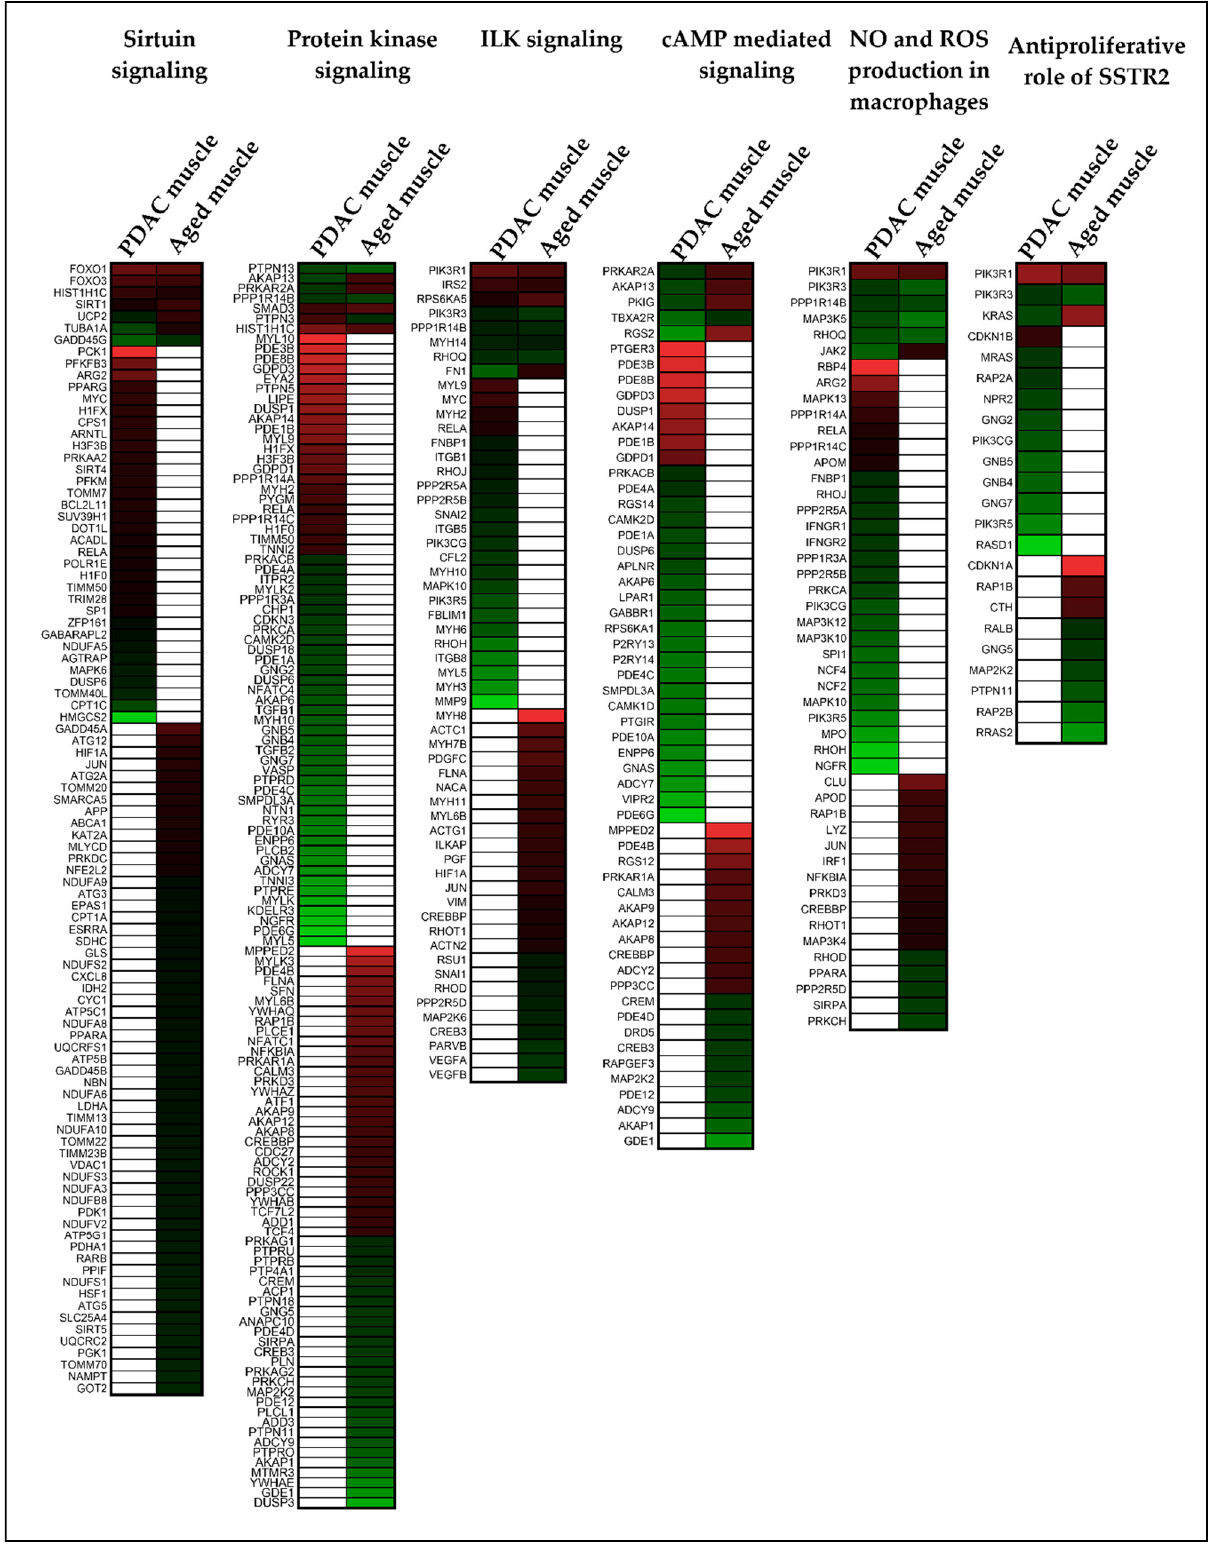
Figure 11. Comparison of age-related transcriptome against PDAC muscle. Six Common pathways were identified between GSE9676 and IU PDAC muscle dataset. Heatmap for each pathway indicate that genes identified in aged muscle dataset and PDAC muscle wasting dataset are predominantly different. Red and green color represent up and downregulated genes, respectively.